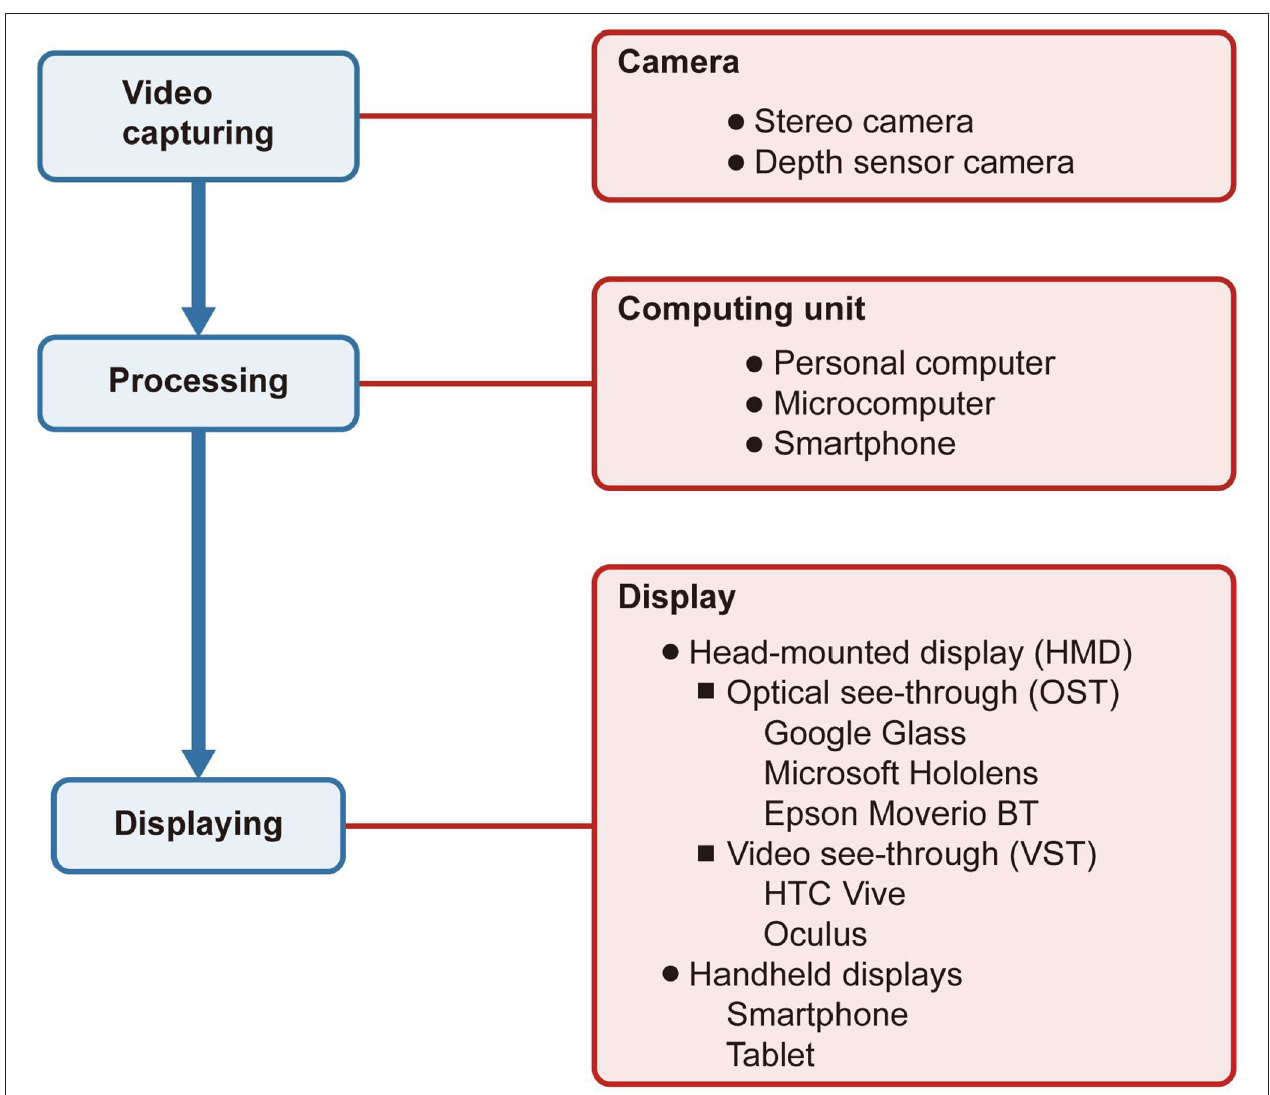
FIGURE 1 | Structure of an augmented reality system in ophthalmology. The boxes filled in blue indicate the system’s procedures, while the boxes in red indicate the devices connected with the procedures. The camera captures the natural environment and then transmits it to the computing unit for processing. Finally, the processed information is reflected on the